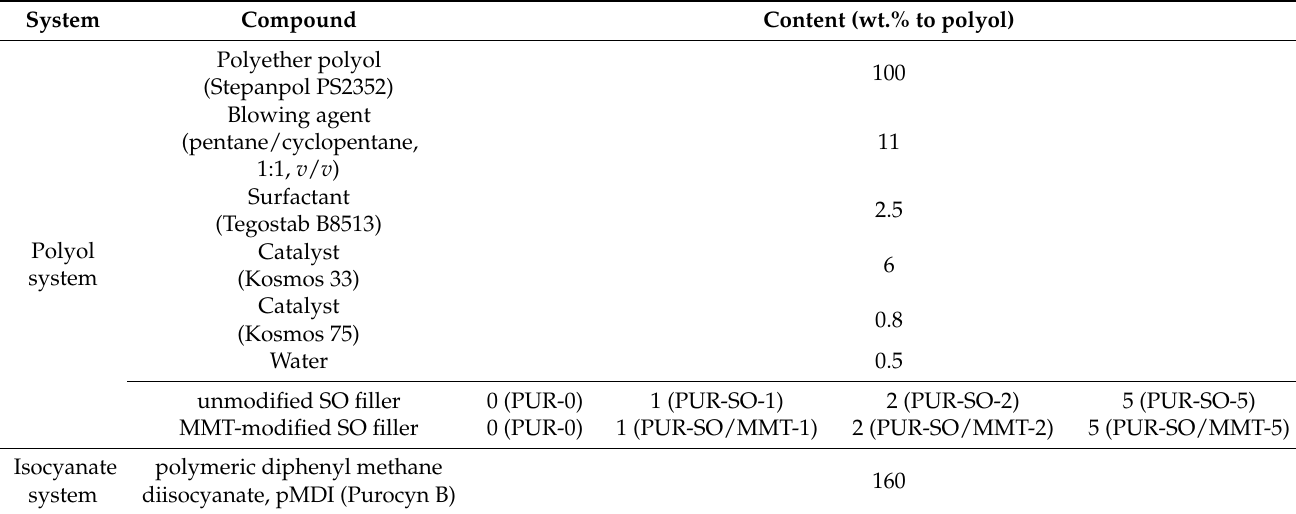
Table 4. Chemical formulas of PUR composites prepared in the following